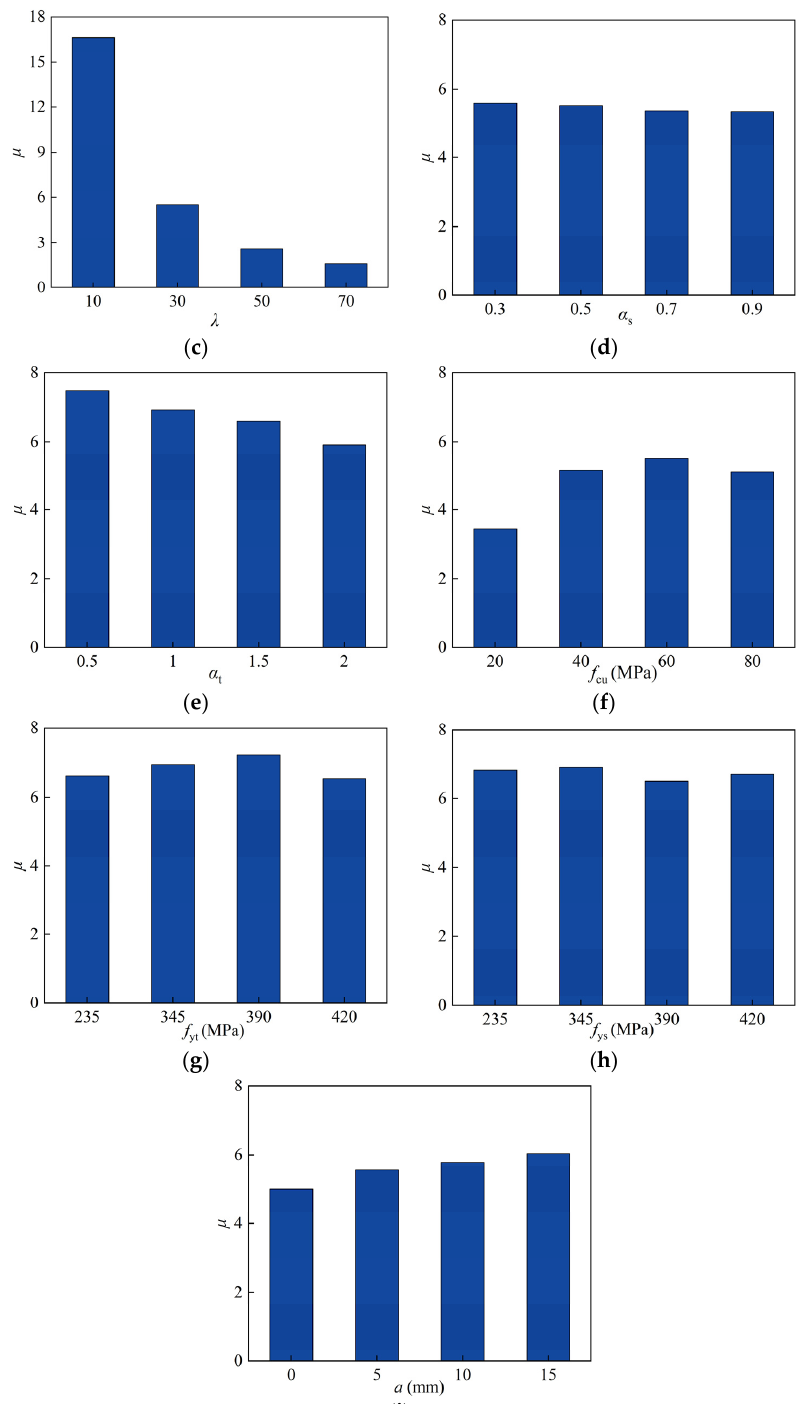
Figure 19. The different parameters on the ductility coefficient: ( a ) Heating time; ( b ) Axial compression ratio; ( c ) Slenderness ratio; ( d ) Profiled steel ratio; ( e ) Steel tube ratio; ( f ) Concrete cubic compressive strength; ( g ) Yield strength of steel tube; ( h ) Yield strength of profiled steel; ( i ) Protective layer thickness.